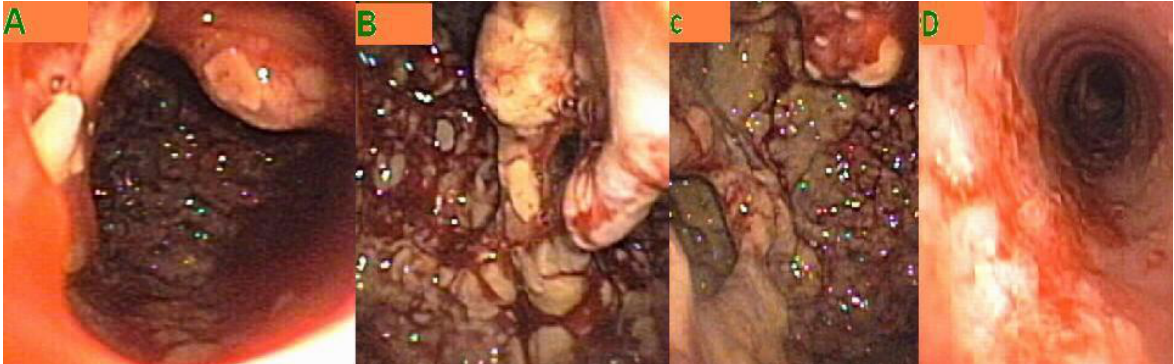
FIGURE 2. Bronchoscopic views showing (A) the entrance of the anterior segment of the right upper lobe of the lung contiguous with an opening to a right-sided cavity, (B, C) necrotic material inside the cavity in the right upper lobe, and (D) white plaques in the tracheal